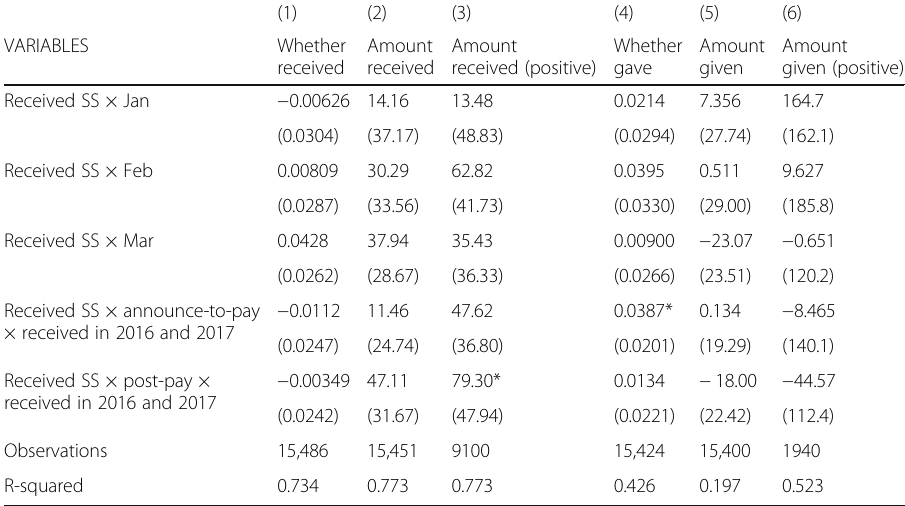
Table 14 Robustness check for private cash transfers — accounting for misreporting of SSS